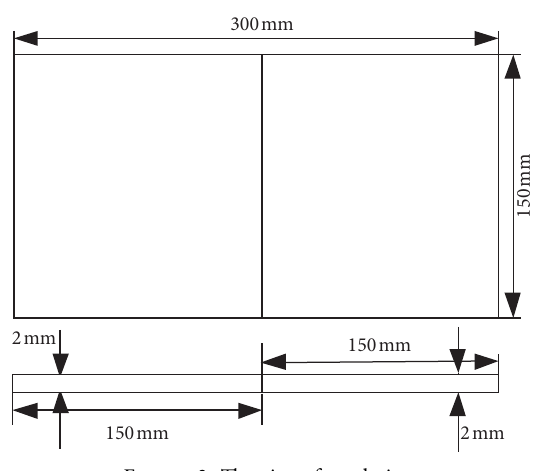
Figure 2: The size of